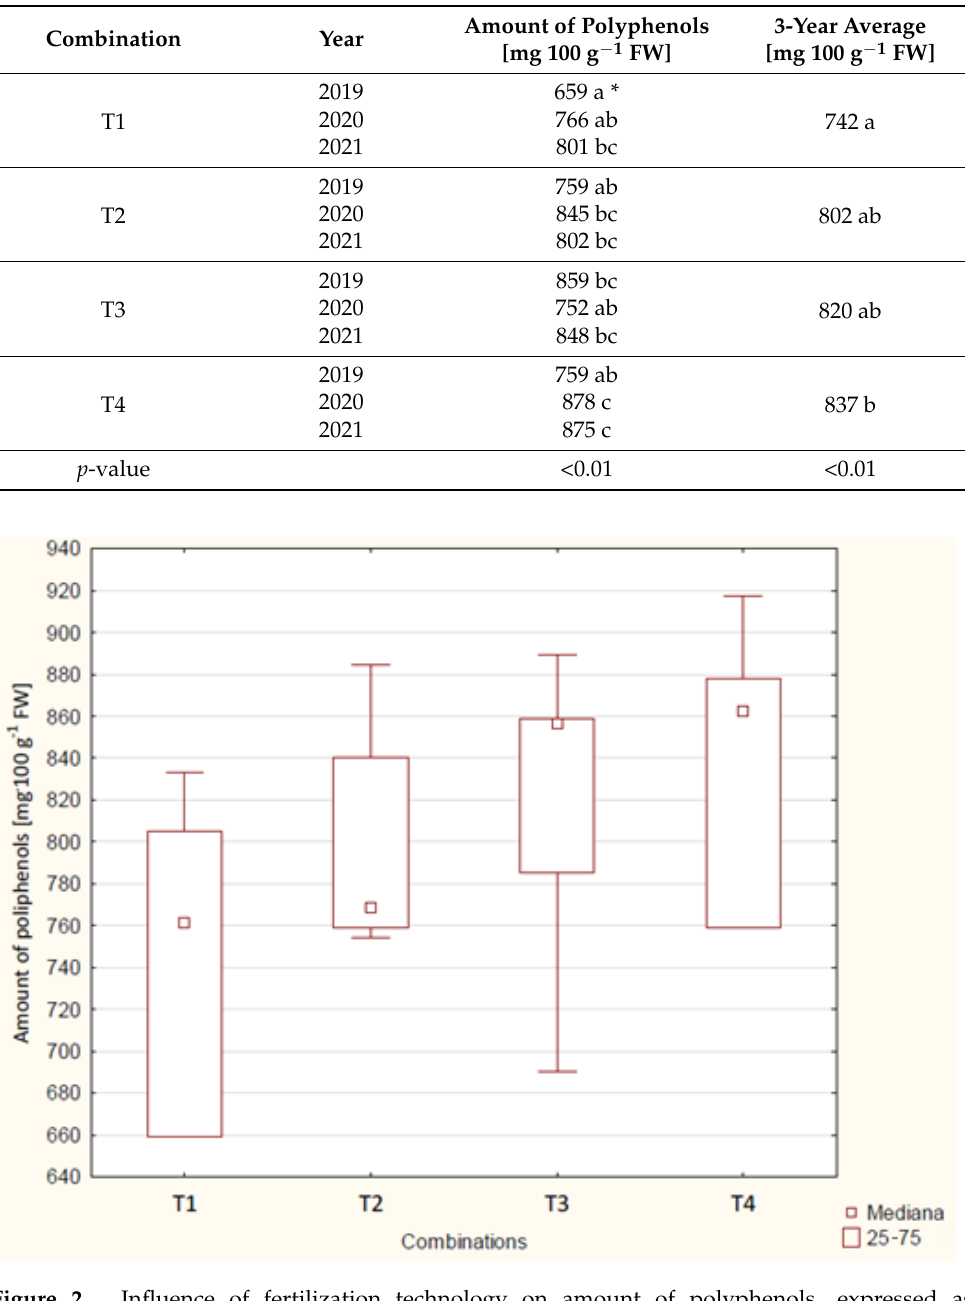
Figure 2. Influence of fertilization technology on amount of polyphenols, expressed as mg 100 . g –1 FW; average per year and over three years of